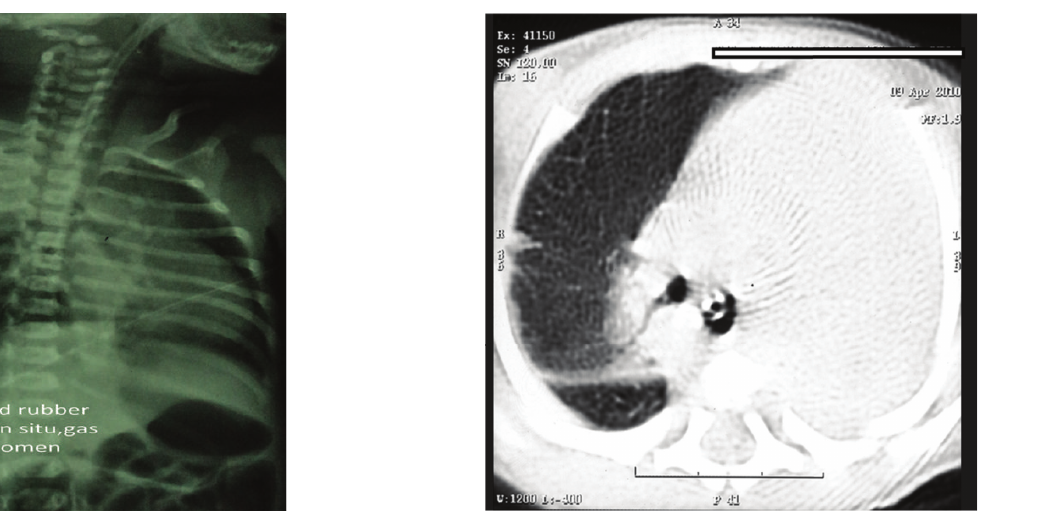
Figure 1: Tracheoesophageal fistula, red rubber catheter in situ.